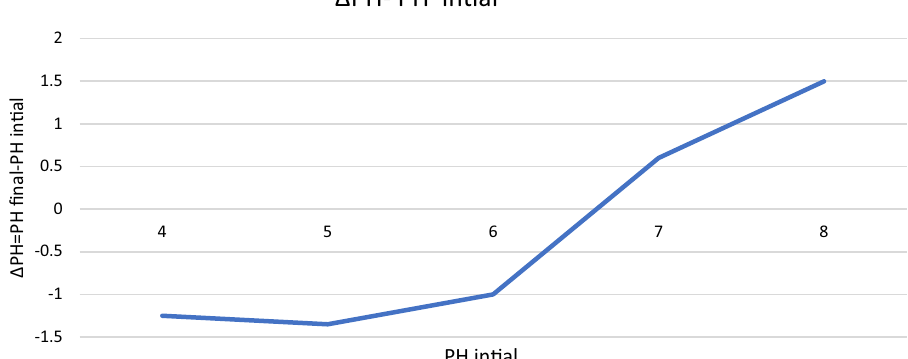
Figure 7. ∆PH–PH intial diagram of magnetic nanobiocomposite.